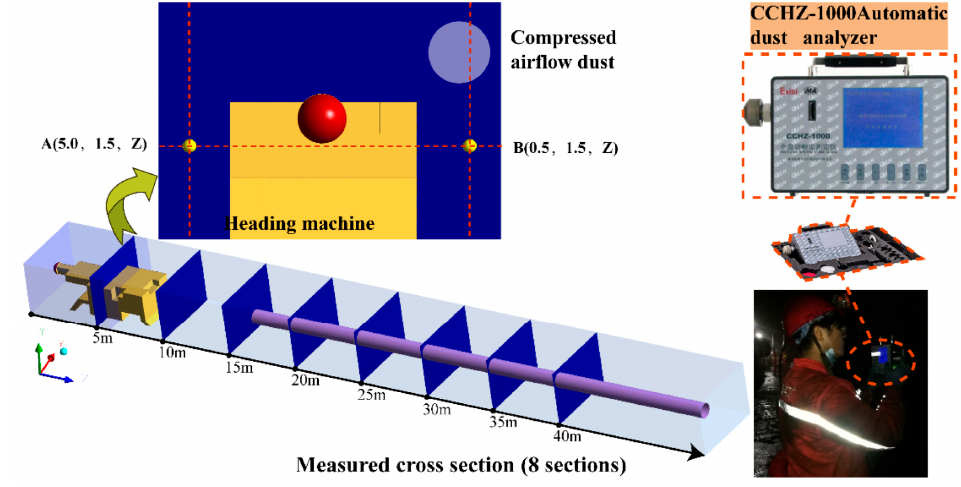
Figure 20. Dust concentration field measurement chart (take model of dynamic tunneling as an ex- ample).